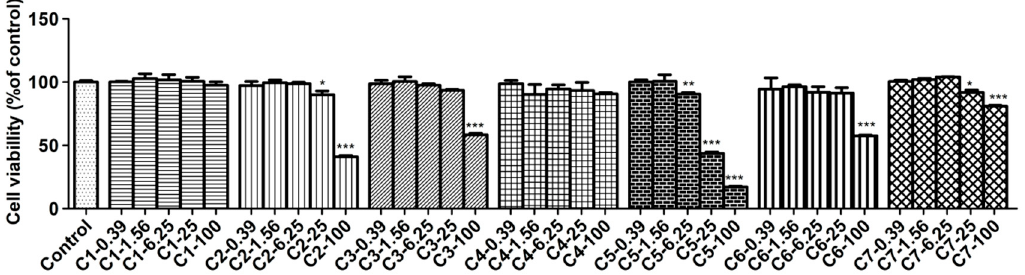
Figure 4. The effects of compounds on cell viability in LPS-induced RAW264.7 cells. RAW264.7 cells were treated with LPS (1 µ g/mL) without or with compounds (0.39–100 µ M) for 24 h. Cell viability was determined by MTT assay. Data are expressed as the mean value ± SD ( n = 3). *** p < 0.001, ** p < 0.01, * p < 0.05 as compared to the control.